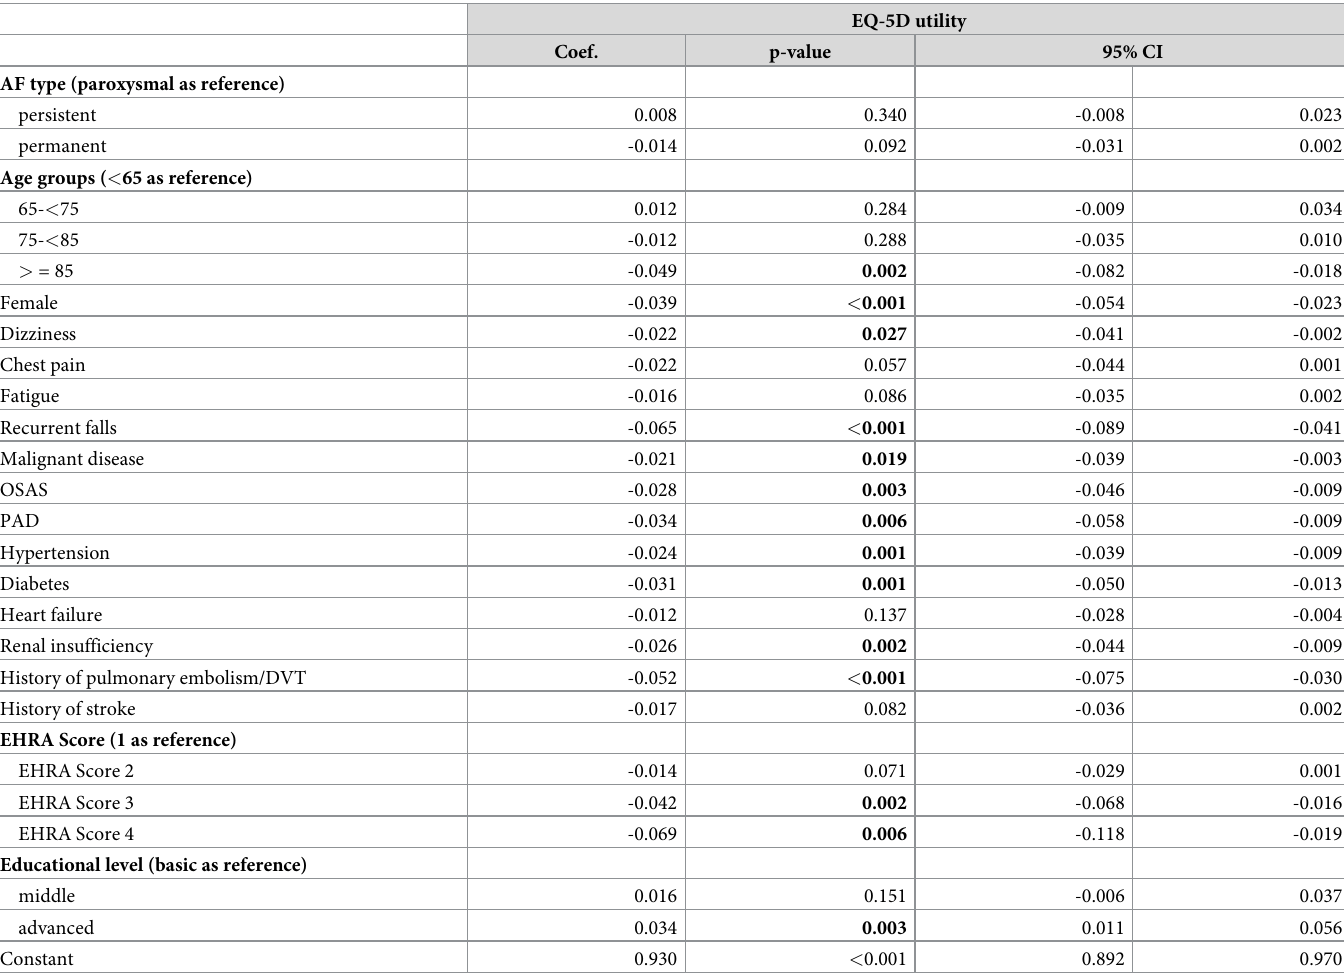
Table 4. Multivariable regression analysis: Predictors of utility in AF patients. Joint p values: AF type p = 0.054, age p < 0.001, EHRA Score p = 0.001, Education level p = 0.004. Study centre was included as a random effect variable in the model. OSAS, obstructive sleep apnoea syndrome; PAD, peripheral artery disease; DVT, deep vein thrombosis; EHRA, European Heart Rhythm